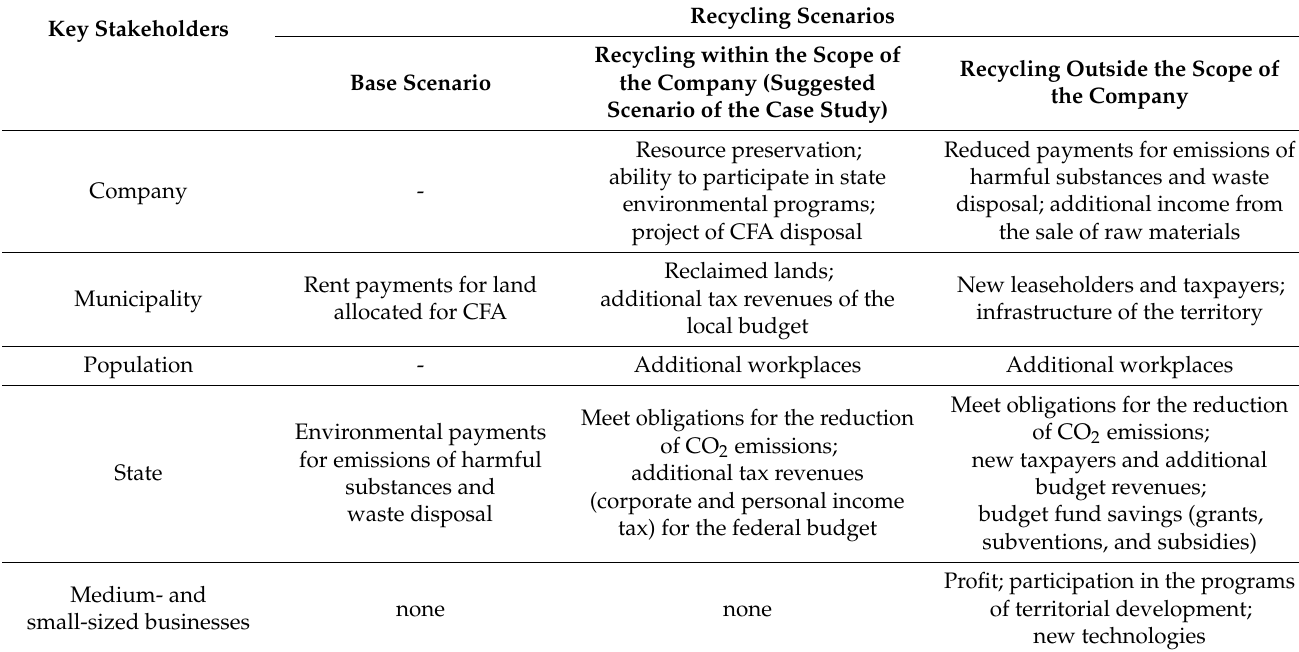
Figure 4. Recycling scenario outside the scope of the CFA producing company. Source: designed by authors. Table 5. Limitations regarding stakeholder expectations for CFA recycling. Source: designed by authors.